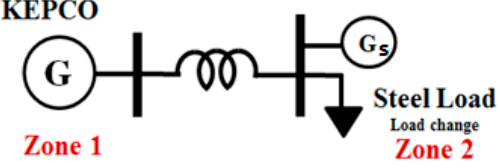
Figure 27. Power system model with customer-owned generator.